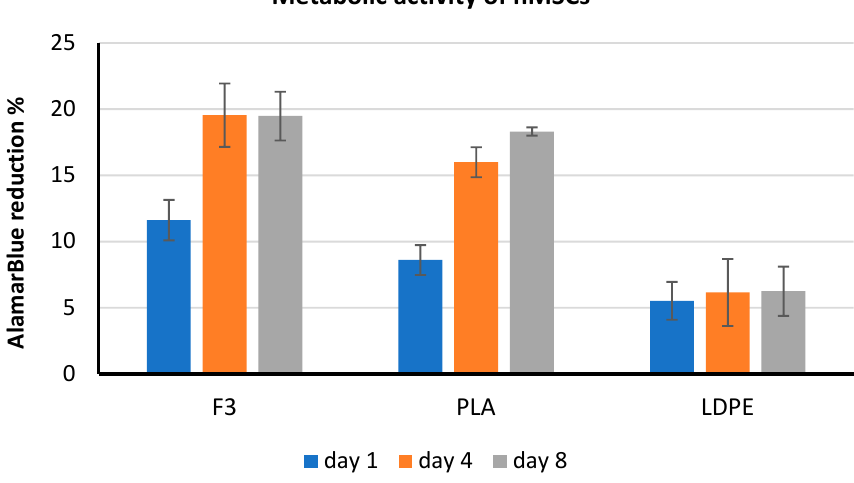
Figure 10. Results of AlamarBlue ® test performed with hMSCs.